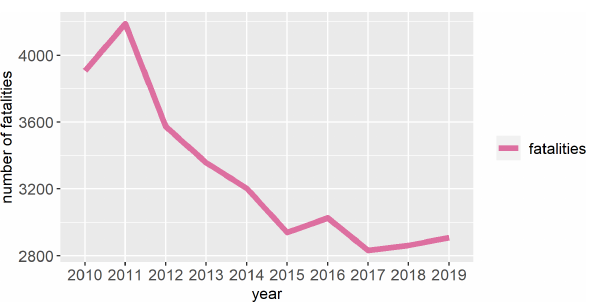
Figure 2: Road traflc fatality rates for 2010–2019